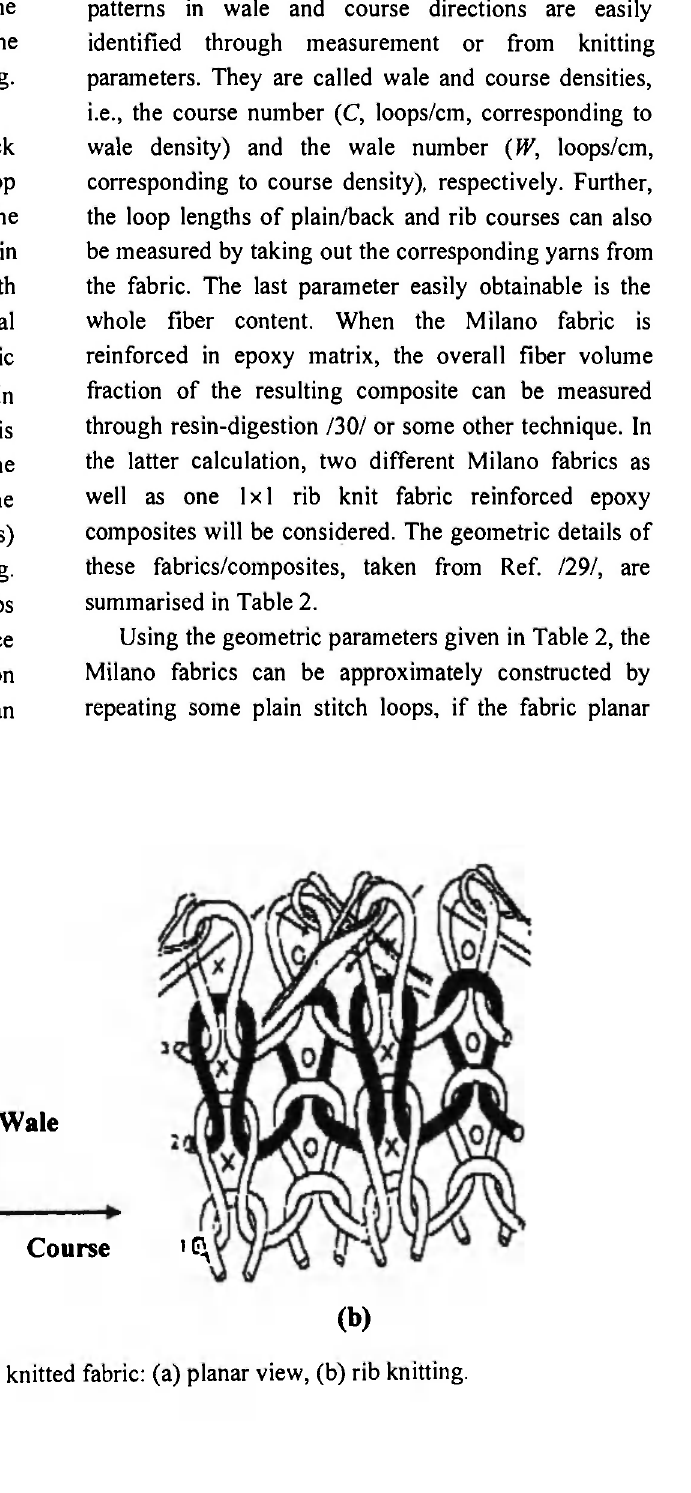
Schematic diagram of a rib knitted fabric: (a) planar view, (b) rib